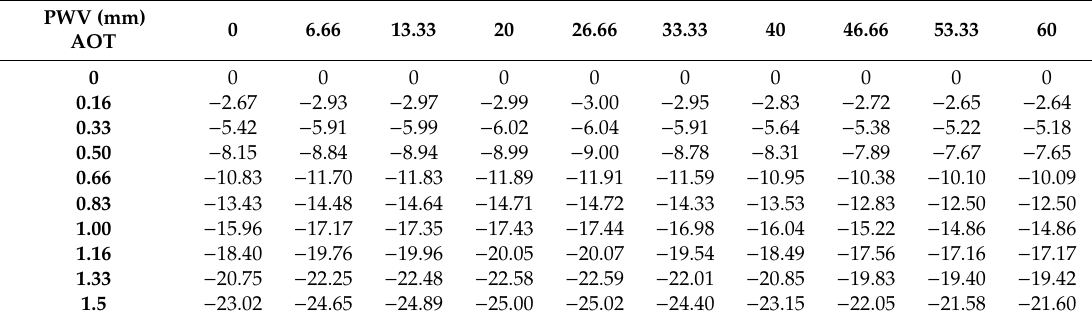
Table 1. Relative di ff erence values (%)describing the AOT e ff ect on shortwave irradiance for each combination of aerosol optical thickness (AOT) and precipitable water vapour (PWV) values.